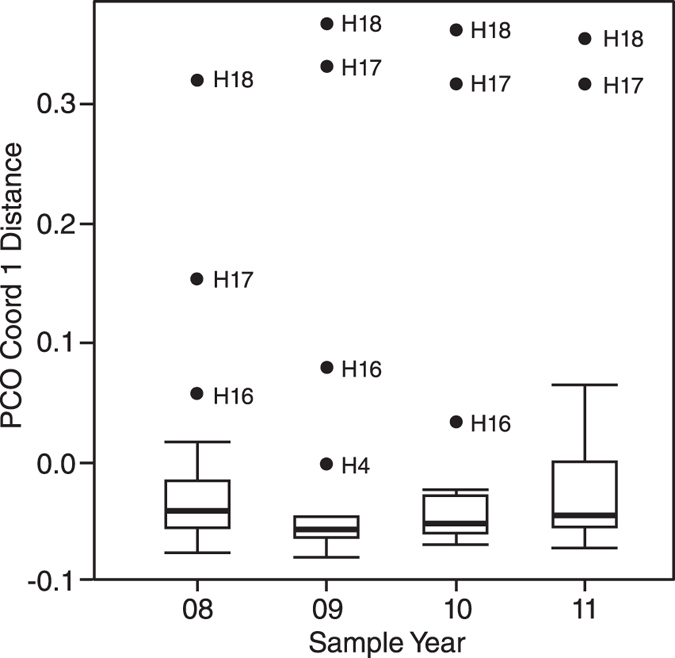
Box plot of PCoA Coordinate 1 distance scores for each of the four sampling intervals.Band inside box = median. Whiskers = +/−1.5*Interquartile range (IQR) and points represent sample sites that fall outside whiskers. Note the reduced IQR directly after Cyclone Hamish (2009), and the broadening of the IQR in subsequent years.